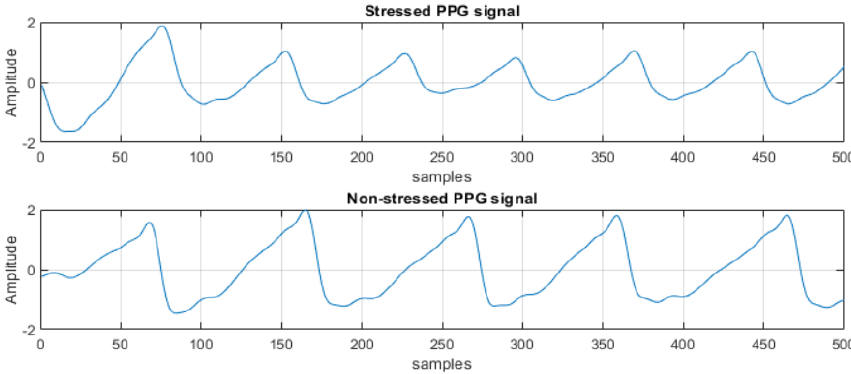
Figure 5. Samples of PPG signals for stressed and non-stressed conditions.